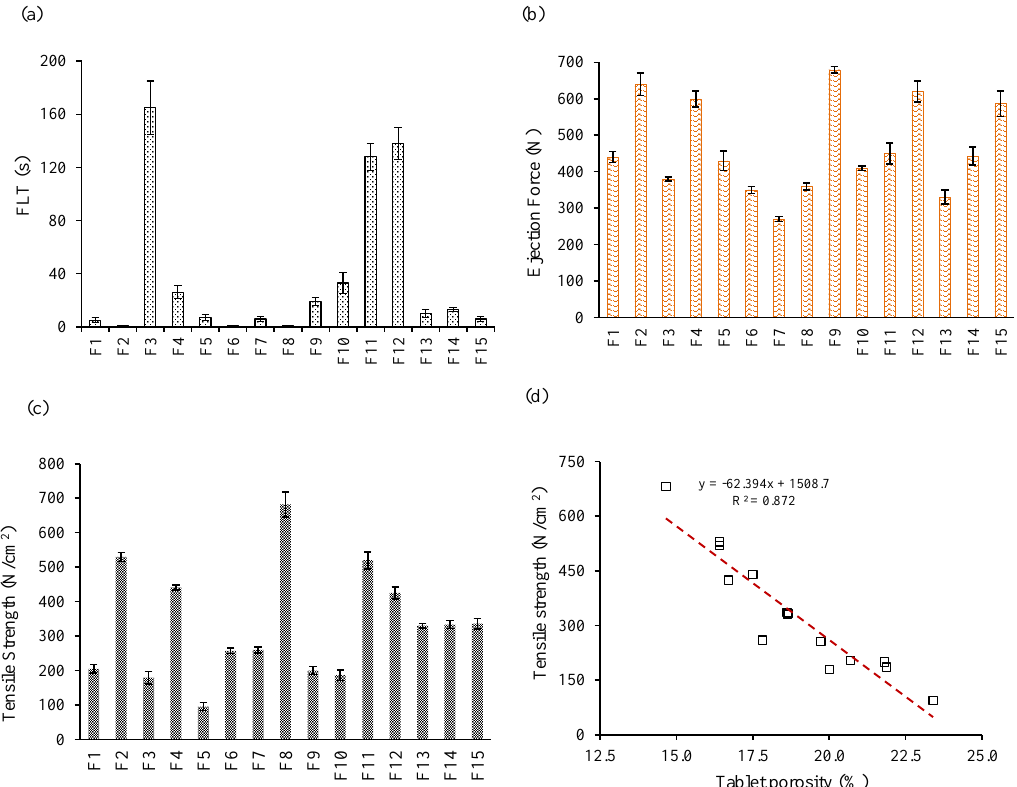
Figure 7. Figure 7. Evaluation of tablet properties of the BBD experimental formulations ( a ) floating lag time (FLT (s)), ( b ) tablet ejection force (N), ( c ) tablet tensile strength (N/cm 2 ), and ( d ) correlation between tablet tensile strength and tablet porosity